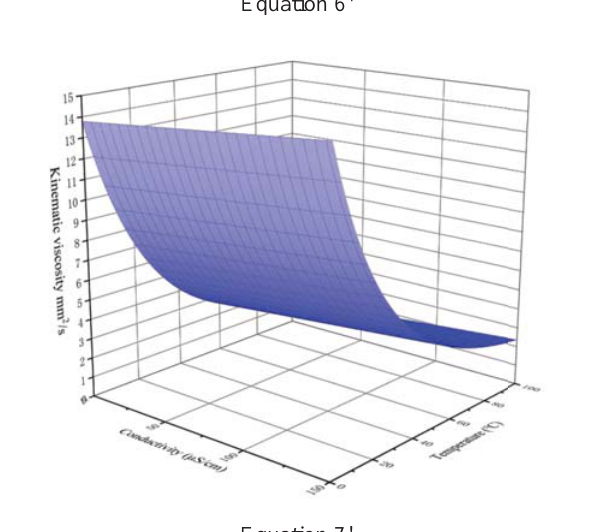
Figure 6: The nonlinear surface fitting of kinematic viscosity, conductivity and temperature of Jatropha curcas